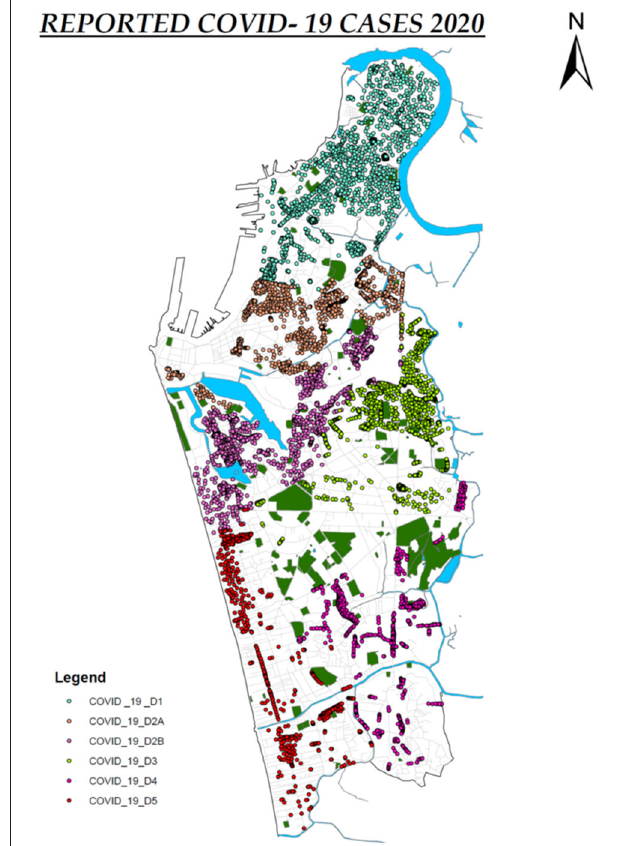
FIGURE 1 | The six districts in the Colombo Municipality Council (CMC) and the locations of cases (identified by qRT-PCR). Each dot denotes an individual